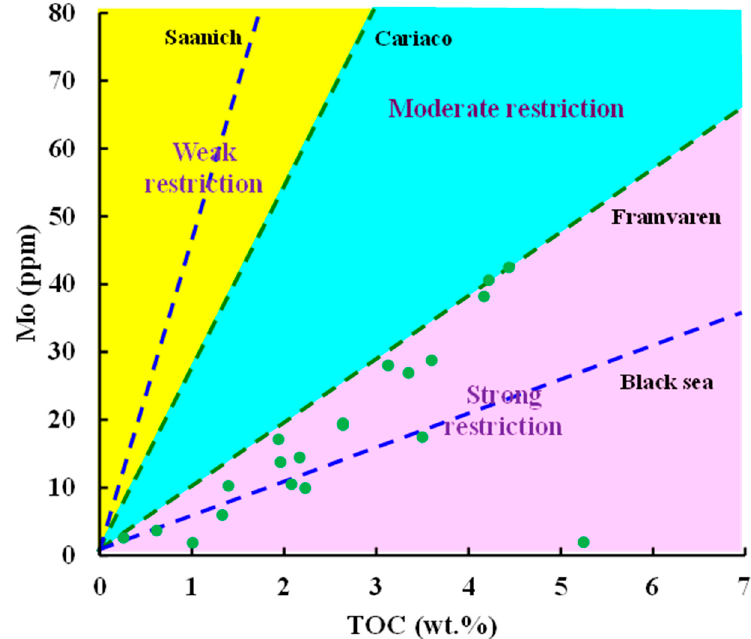
Figure 4. The Mo element and TOC content from the Upper Ordovician Wufeng Formation and Lower part of the Lower Silurian no. 1 section of the Longmaxi Formation in the Jiaoye-1 well. The base map is from Algeo and Lyons [47] and Zhang et al. [39]. See Figure 1 for the well location.